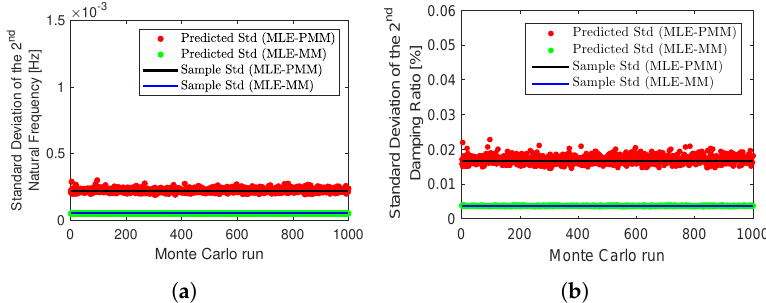
Figure 18. Monte Carlo simulation results for the lattice tower example with 5% of noise level: sample standard deviation of the natural frequencies ( a ) and damping ratios ( b ) (solid line) estimated for the 2nd mode and the corresponding standard deviations predicted from a typical Monte Carlo dataset after 20 iterations of the MLE-PMM